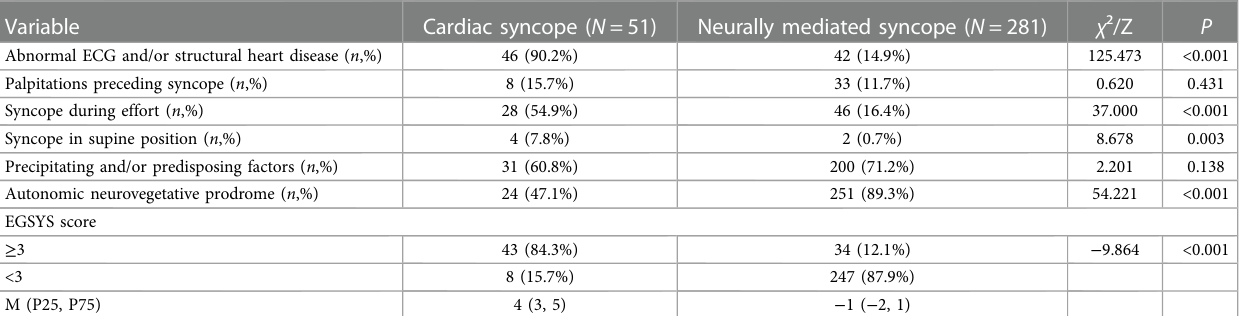
TABLE 4 Comparison of EGSYS risk factors between two groups.